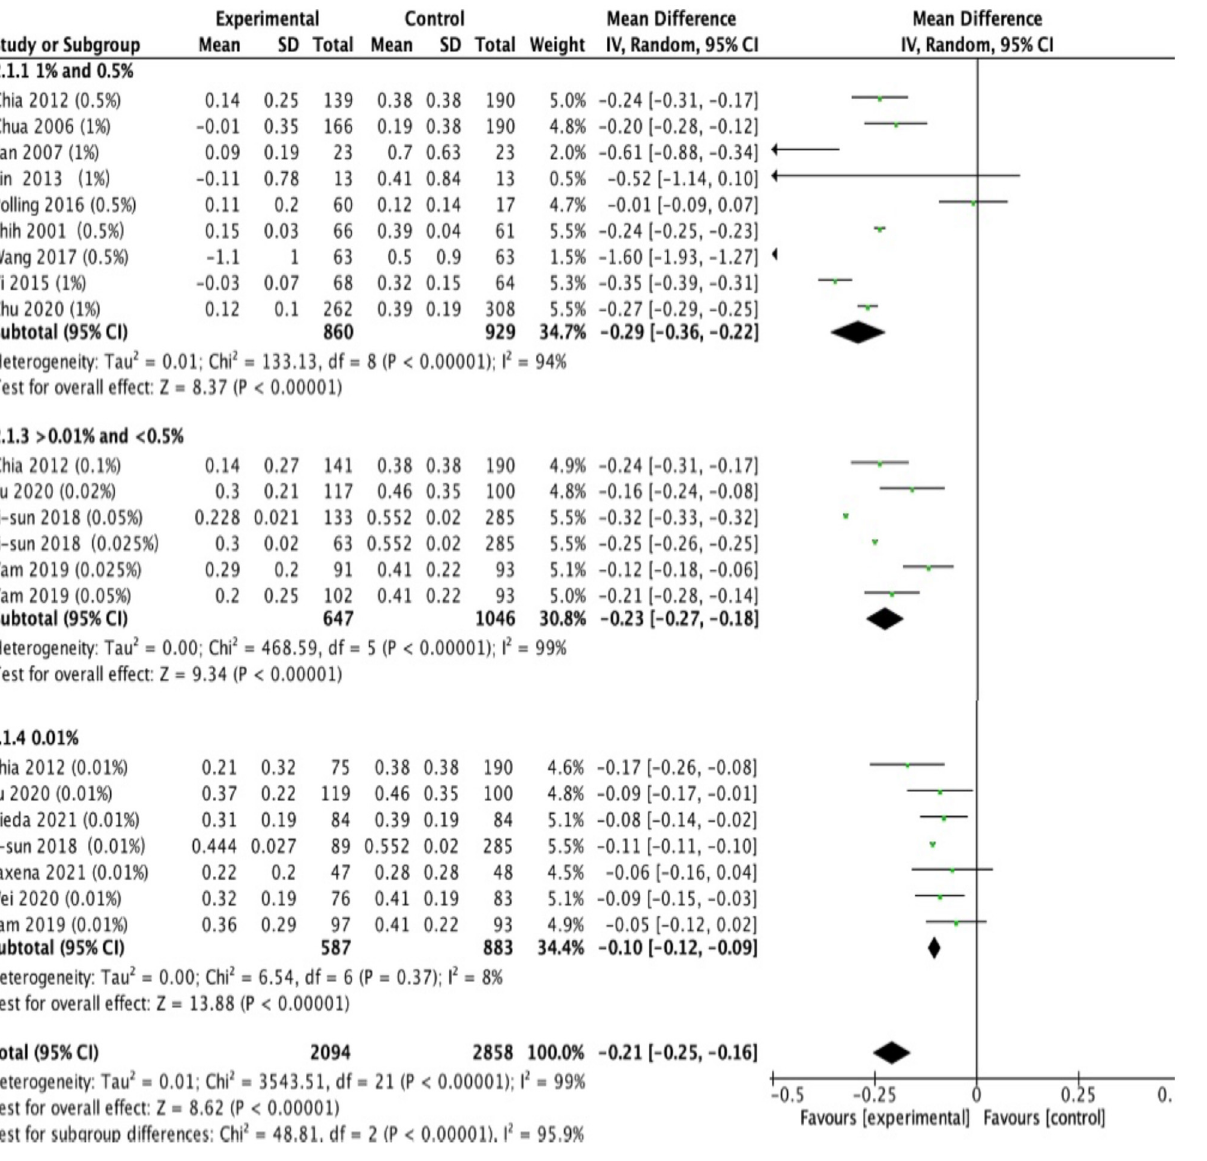
FIGURE 4 | Effects of different doses of atropine on slowing axial elongation (mm/year).